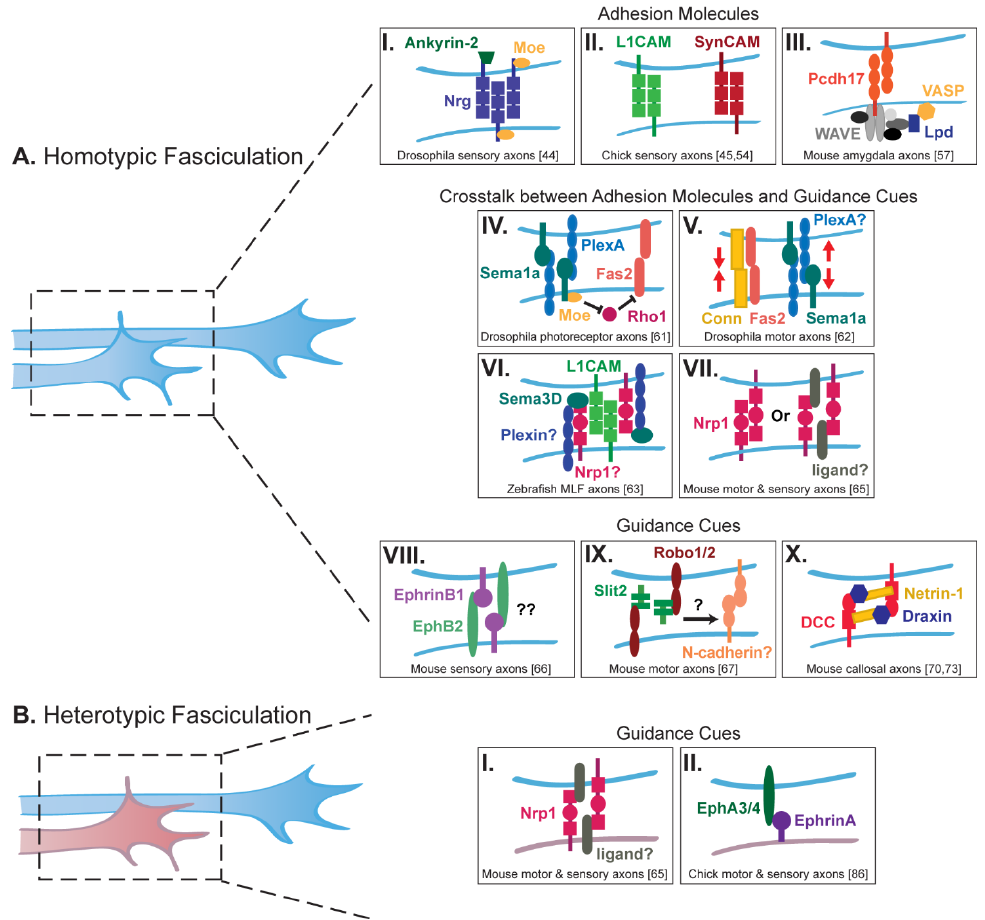
Figure 1. Trans ‐ axonal signaling mediates homotypic ( A ) and heterotypic ( B ) fasciculation. ( AI–III ) Cell adhesion molecules (CAMs) regulate homotypic axon–axon fasciculation. ( AI ) Neuroglian (Nrg) is clustered along the surface of Drosophila sensory axons to mediate homotypic fasciculation [44]. ( AII ) L1CAM and SynCAM both mediate homotypic fasciculation of chick sensory axons [45,54]. ( AIII ) Pcdh17 facilitates trans ‐ axonal homotypic fasciculation in mouse amygdala axons by recruiting the WAVE complex, Lamellipodin (Lpd), and VASP [57]. ( AIV–VII ) Crosstalk between CAMs and classical guidance cues regulate homotypic axon–axon interactions. ( AIV ) Sema1a reverse signaling increases the adhesive function of Fas2 in Drosophila photoreceptor axons [61], while it balances the adhesive functions of Connectin (Conn) and Fas2 in motor axons ( AV ) [62]. ( AVI ) Sema3D signaling likely involving Nrp1 and Plexin co ‐ receptors regulates the expression levels of L1CAM to mediate homotypic fasciculation of zebrafish medial longitudinal fascicle (MLF) axons [63]. ( AVII ) In mouse motor and sensory axons, Nrp1, either on its own or with an unknown ligand, facilitates homotypic axon–axon fasciculation [65]. ( AVIII–X ) Other classical guidance cues also mediate homotypic trans ‐ axonal signaling. ( AVIII ) Ephrin ‐ B1 and EphB2, expressed on mouse sensory axons, may regulate homotypic axon fasciculation by binding in trans [66]. ( AIX ) Slit/Robo signaling mediates homotypic fasciculation of motor axons, possibly by regulating the surface levels of N ‐ cadherin [67]. ( AX ) Interactions between Netrin ‐ 1, Draxin and DCC facilitate fasciculation of mouse callosal axons [70,73]. ( BI–II ) Classical guidance cues also mediate heterotypic trans ‐ axonal signaling. Nrp1, through an unknown ligand, as well as Ephrin-A / EphA signaling, mediate trans-axonal heterotypic fasciculation of motor and sensory axons